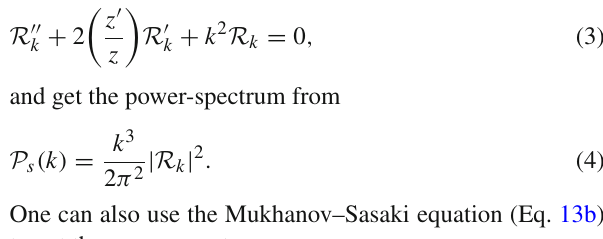
Table 1 The table contains the prior range we used for the inflationary potential parameters Parameters